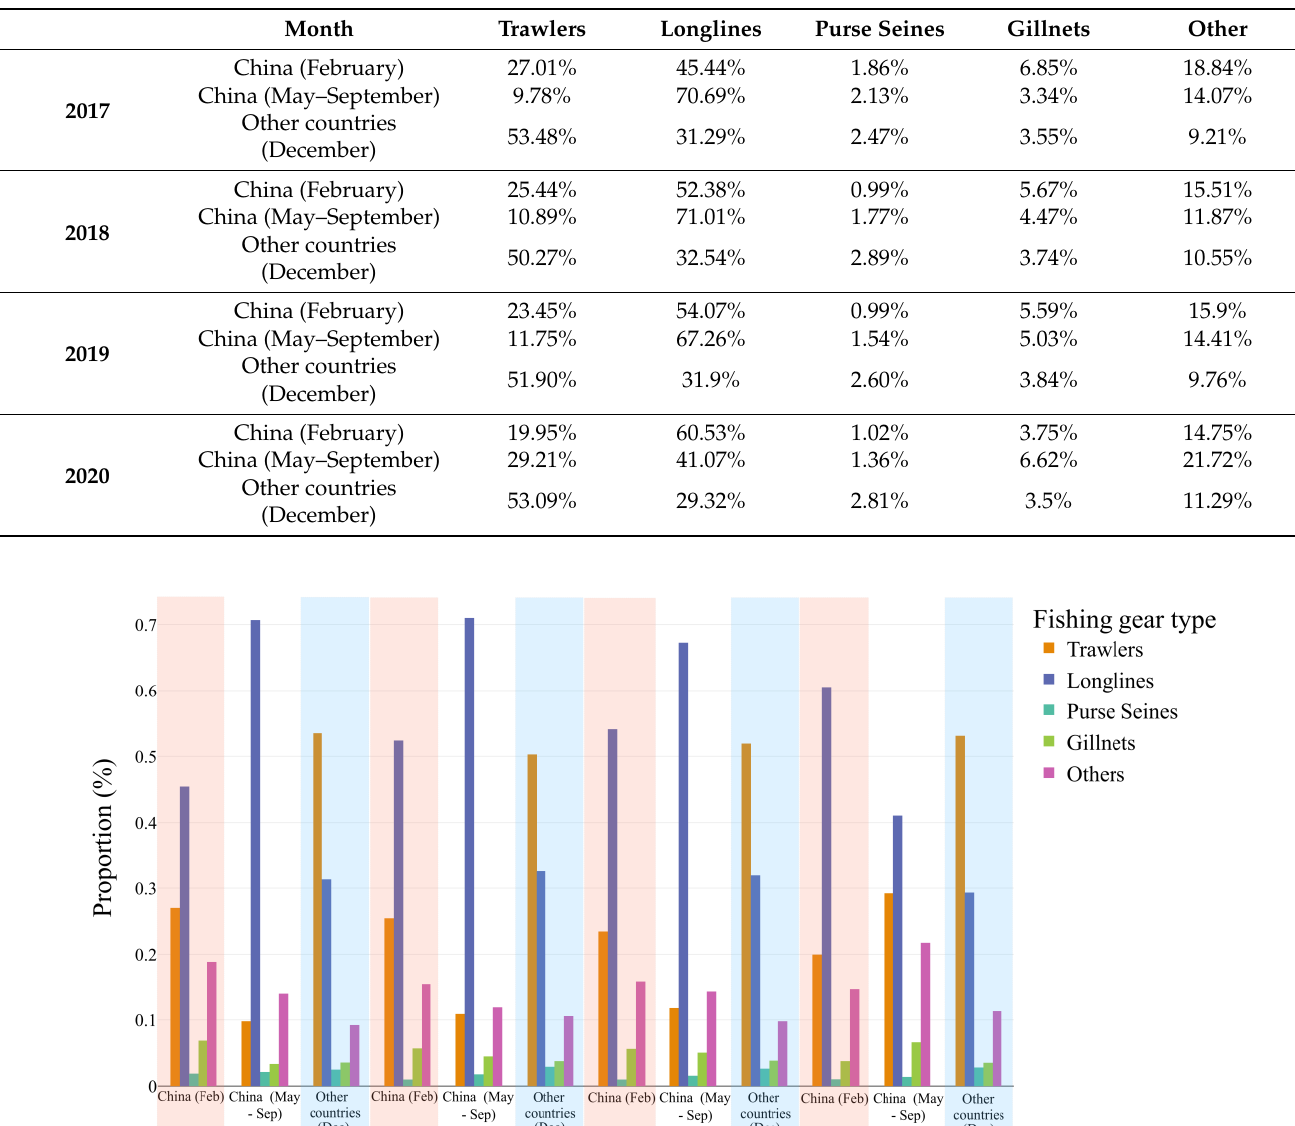
Table 3. Proportion of fishing gear under the influence of culture and policy on fishing effort in China and other countries.